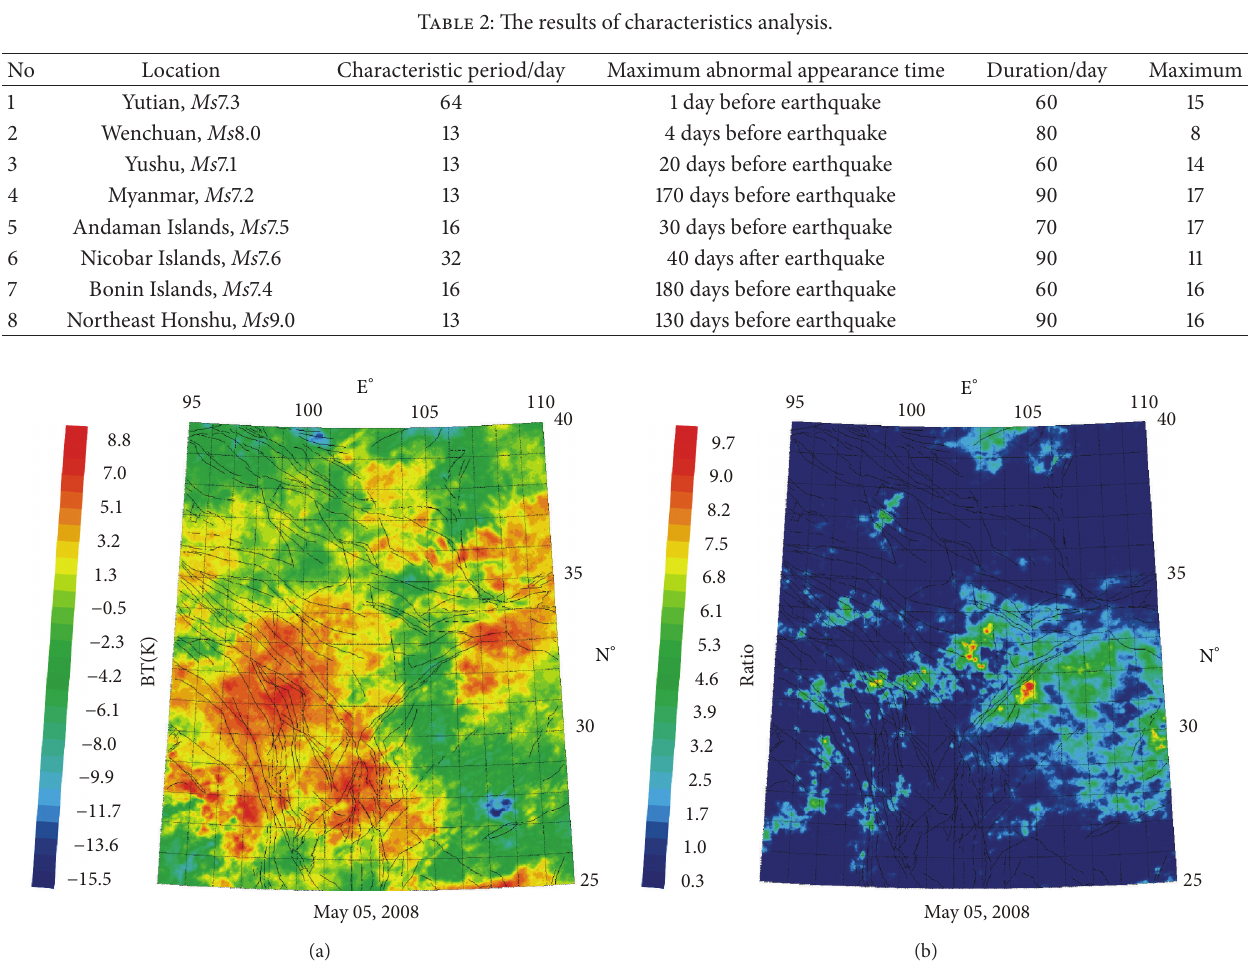
Figure 2: Relative power spectrum (RPS) result ((a) wavelet transform data; (b) relative power spectrum